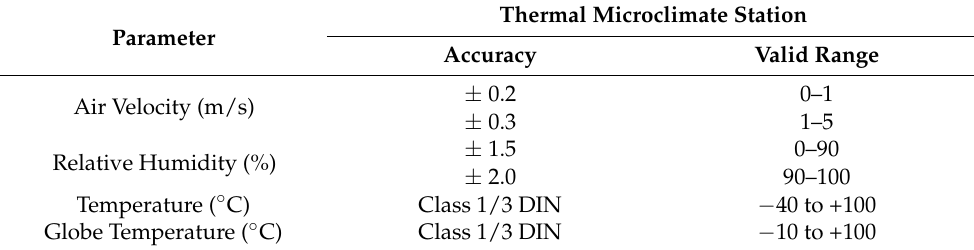
Table 3. Physical parameters and instrument accuracy.